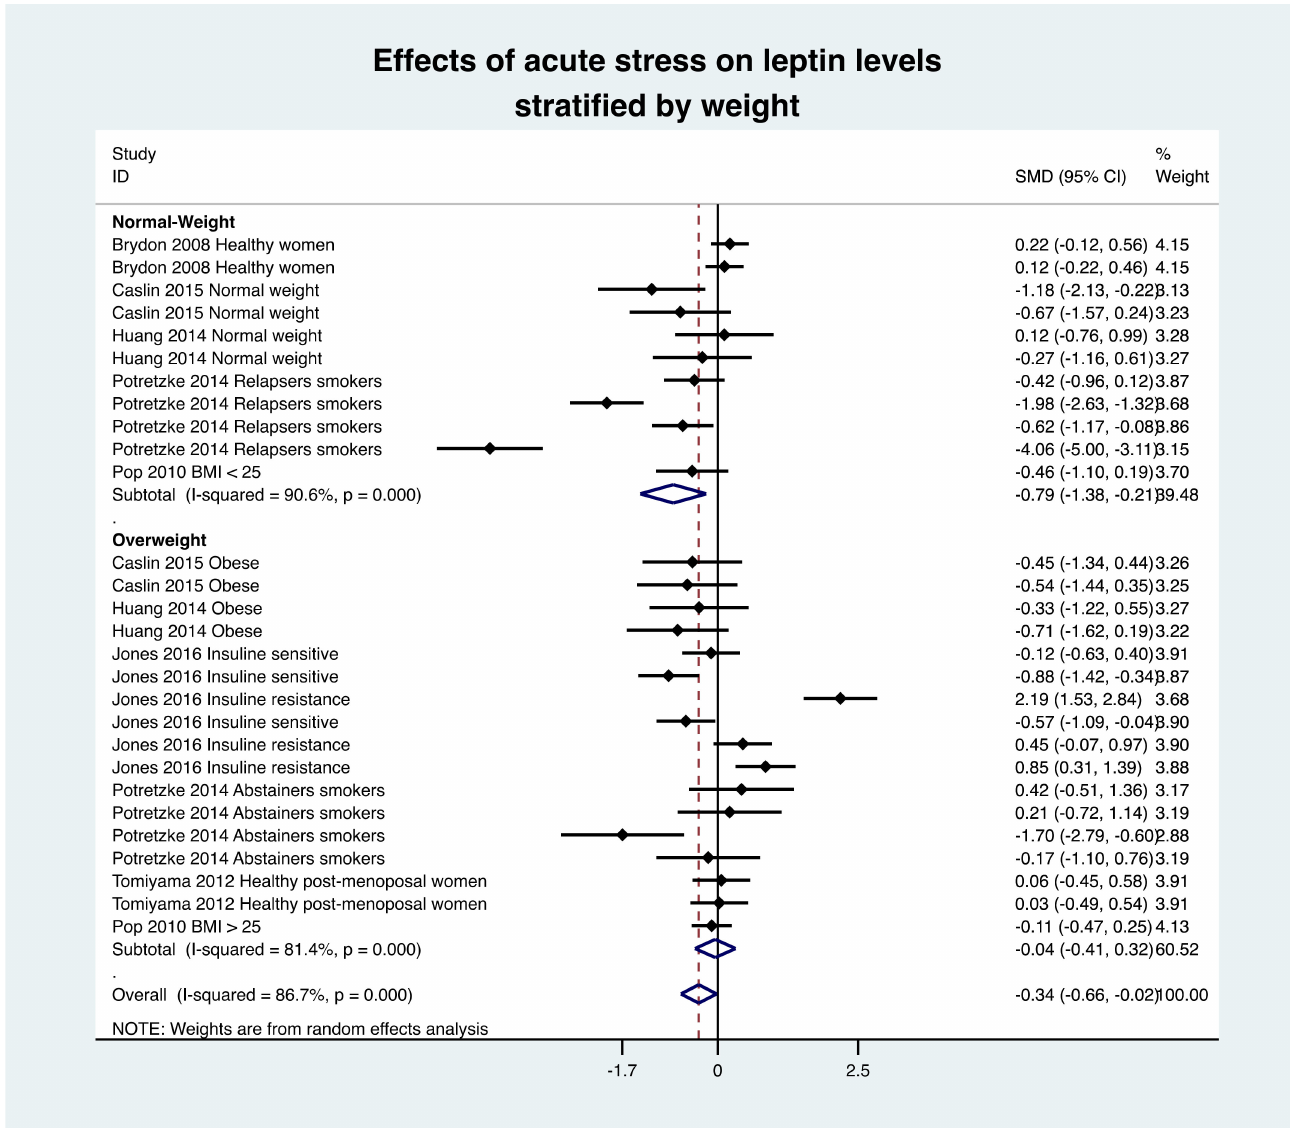
Figure 4. Meta-analysis of leptin levels following acute stress compared to baseline levels, stratified by weight of individuals. SMD, standardized mean